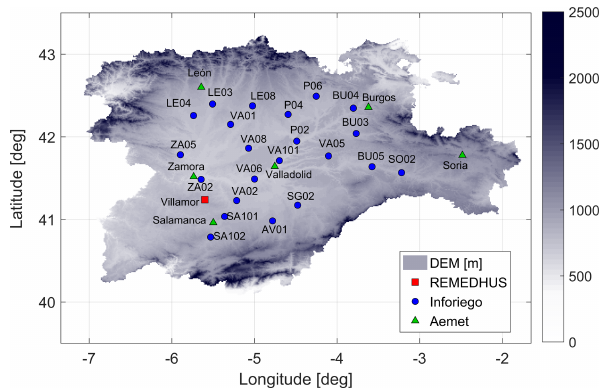
Figure 1. Digital elevation model (DEM) map of the Castilla y León region showing the location of the REMEDHUS, Inforiego and AEMet